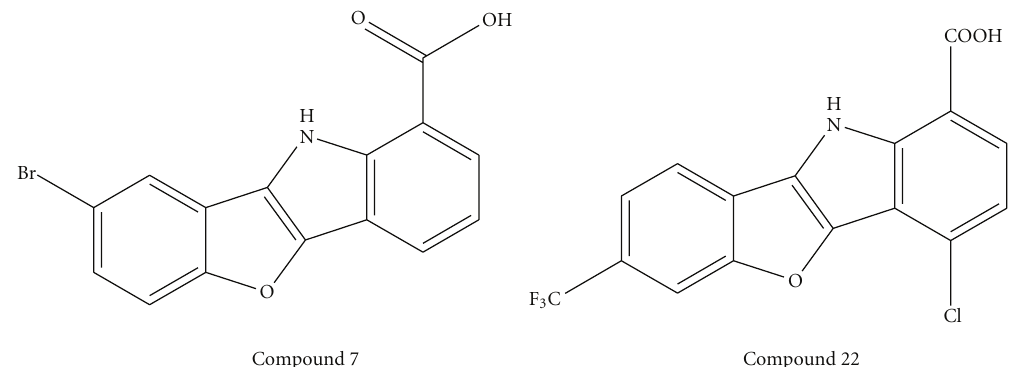
Figure 1: Structures of compound 7 ( 10 H -benzo[4,5]furo[3,2- b ]indole) and compound 22 (4-chloro-7-trifluoromethyl-10 H- benzo[4,5]furo[3,2- b ]indole-1-carboxylic acid).